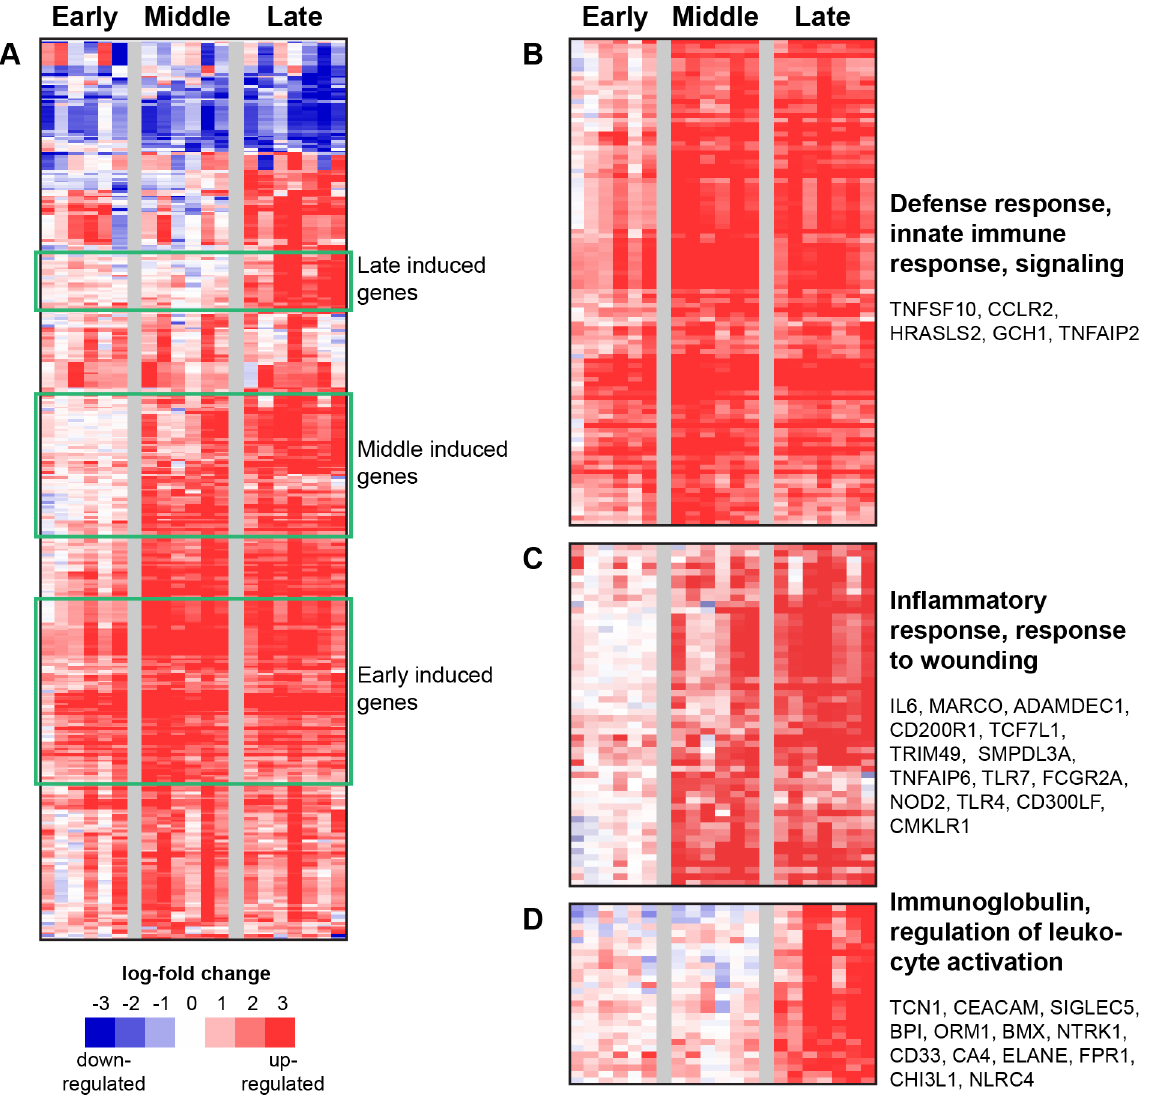
Figure 2. Strongly upregulated genes in LASV-exposed NHP. (A) Data had been zero-transformed using the pre-exposure control sample from each individual monkey to normalize for animal-intrinsic signatures and establish a baseline. Data were then filtered to identify 361 genes that showed at least a 2.5 log2-fold differential expression, and then hierarchically clustered. Each row in the heatmaps represents data from an individual gene, and each column represents the individual PBMC sample taken at a specific time point. Samples from the dataset were grouped into early (days 2–3), middle (days 6–8) and late (days 10–12) disease categories based on the day the sample was collected post-viral challenge. Red and blue colors denote expression levels greater or less than baseline (white), respectively. Green boxes identify significant clusters of genes induced during early, middle, and late disease, and are labeled accordingly. An expanded view of these gene clusters is shown in (B), (C), and (D). The most significant functional groups (assigned by DAVID, p -value , 0.001) found in the respective clusters are listed to the right of the heatmaps, along with the names of some representative genes.